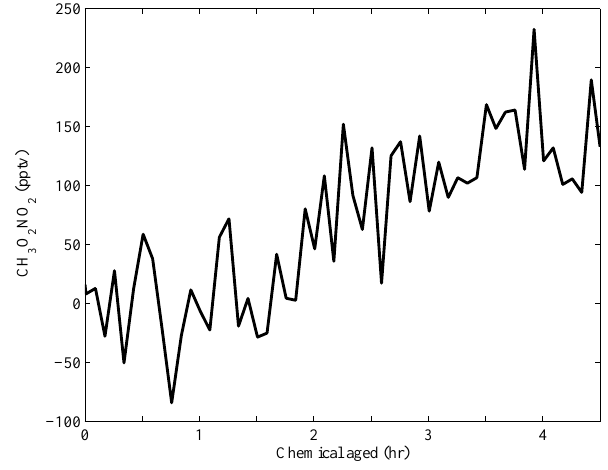
Figure 9. Five-minute-averaged time series of the chemical evo- lution of CH 3 O 2 NO 2 downwind from convection from a flight on 21 June 2012 during DC-3. The x axis shows the age of the air parcel that the DC-8 started sampling at approximately 12:00UTC (0h), which was the local